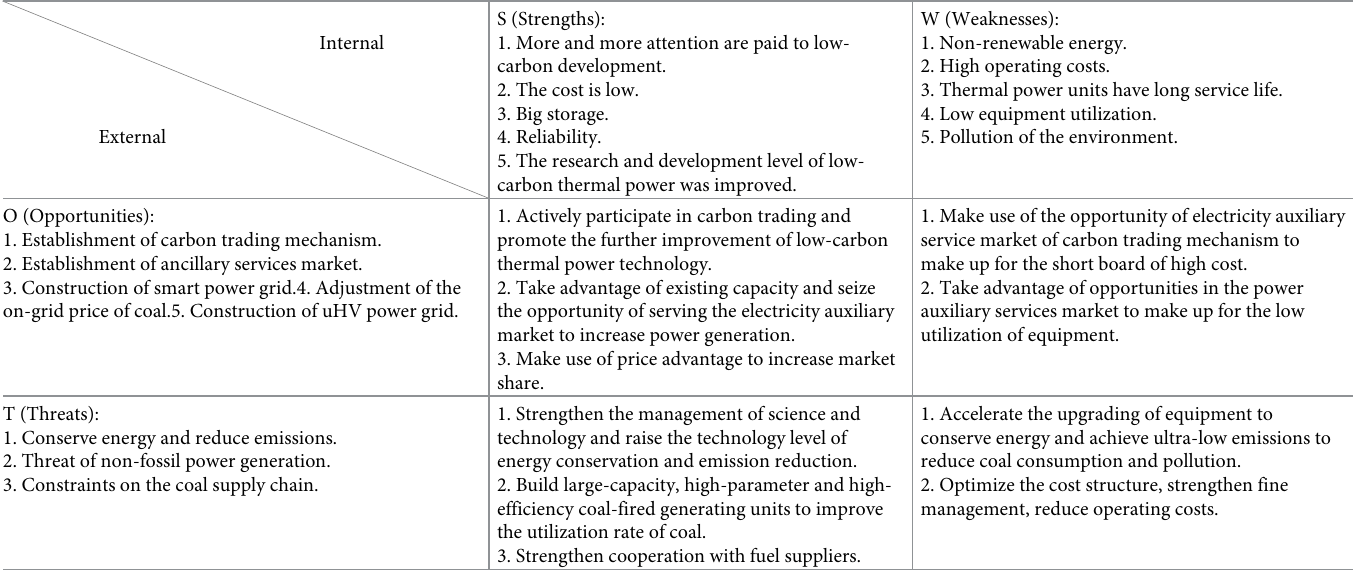
Table 11. The SWOT analysis of